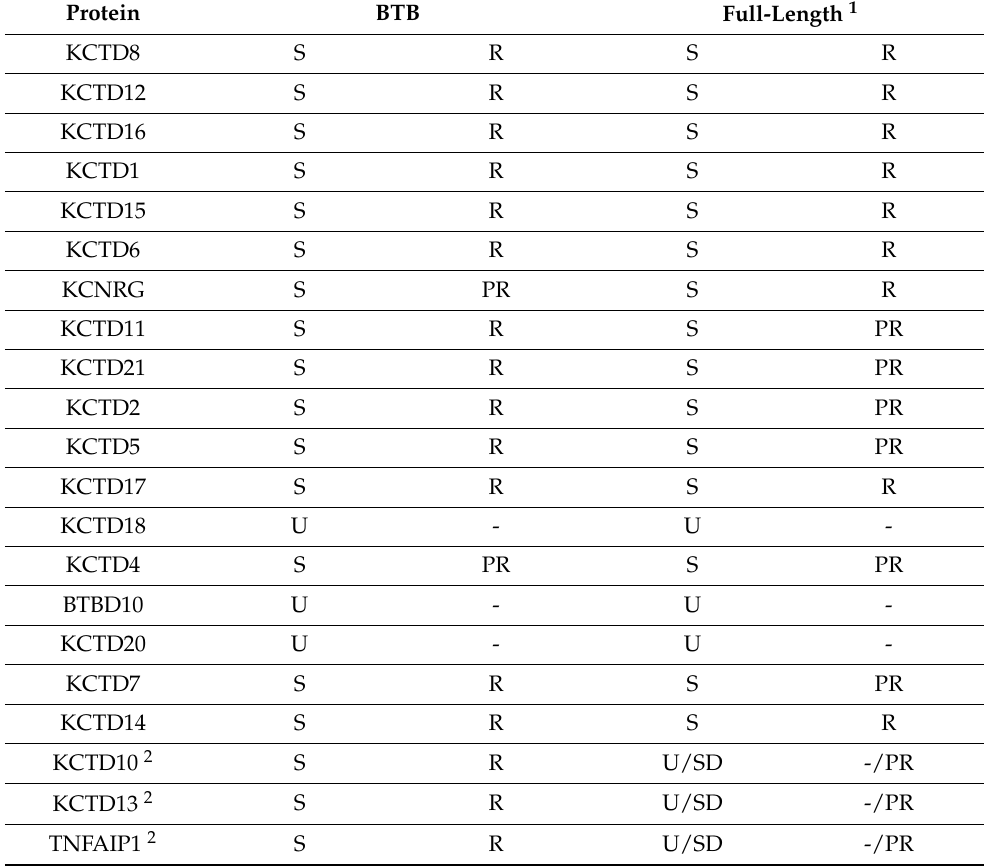
Table 1. Qualitative assessment of the predictions. For each prediction in the left column, the stability of the oligomeric assembly (S = stable; U = unstable as a pentamer) is reported; the right column shows the reliability of the prediction (R = reliable; PR = partially reliable) based on a visual inspection of the PAE matrices. Proteins predicted to form stable dimers (SD) are also